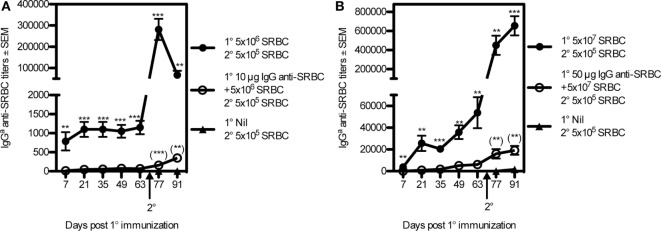
IgG suppresses the induction of immunological memory. BALB/c mice were immunized with 5 × 106 sheep red blood cell (SRBC) ± 10 μg IgGb anti-SRBC+ or (A) or 5 × 107 SRBC ± 50 μg IgGb anti-SRBC (B). And, 70 days after priming, all mice were boosted with 5 × 105 sheep red blood cells (SRBCs). An additional, unprimed, group also received 5 × 105 SRBC at this time point (filled triangles). Serum IgGa anti-SRBC titers were assayed in enzyme-linked immunosorbent assay. p-Values for comparisons between mice primed with IgG anti-SRBC and 5 × 107 SRBC vs. 5 × 107 SRBC alone are given without parentheses. Comparisons between mice primed with IgG anti-SRBC and SRBC and boosted with 5 × 105 SRBC vs. naive mice “boosted” with 5 × 105 SRBC alone are given within parentheses. Data are representative of at least three experiments per antigen dose (n = 5–8/group). ns, p > 0.05; **p < 0.01; ***p < 0.001.